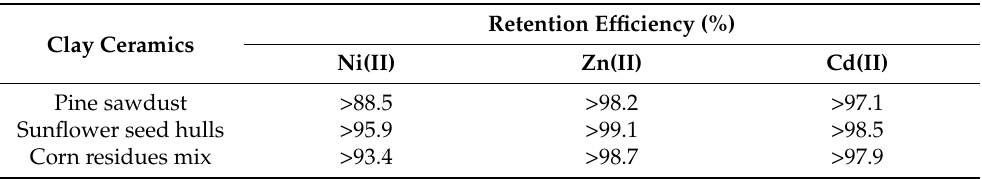
Table 3. Heavy metal retention efficiency for clay ceramics prepared from spent adsorbent with the mixture of heavy